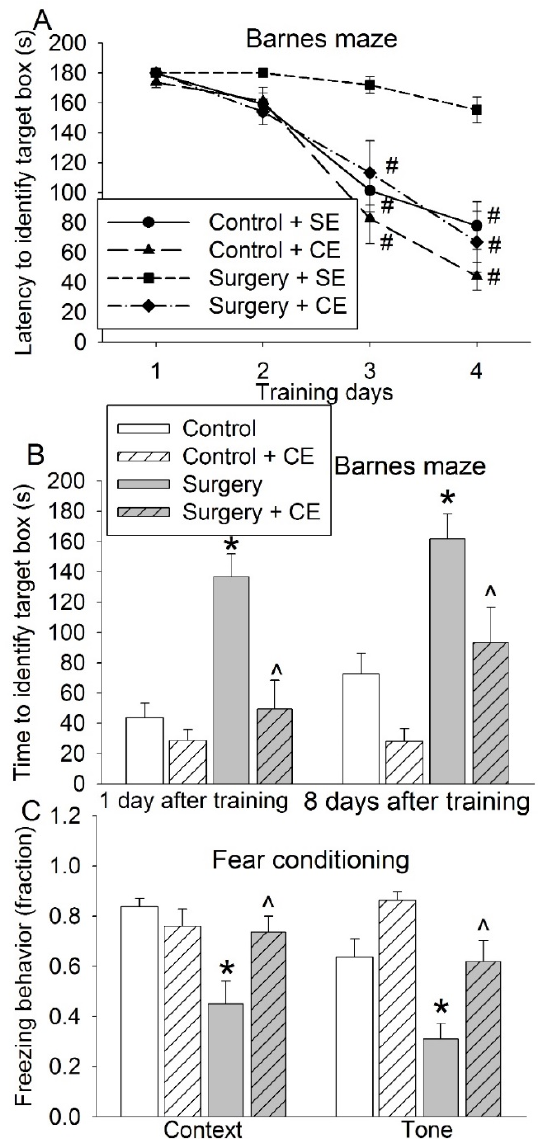
Figure 6. Effects of cognitive enrichment and surgery on learning and memory. Eighteen-month-old mice were subjected to right carotid artery exposure and cognitive enrichment. They were starting to be tested by the Barnes maze and fear conditioning 2 weeks after surgery. ( A ) Performance